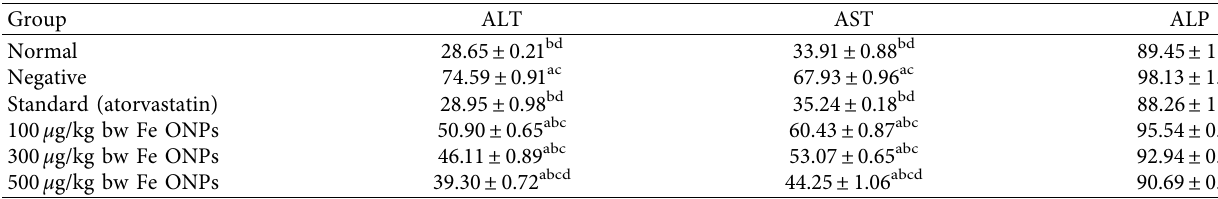
Table 3: Effect of iron oxide nanoparticles on liver biomarkers in U/L